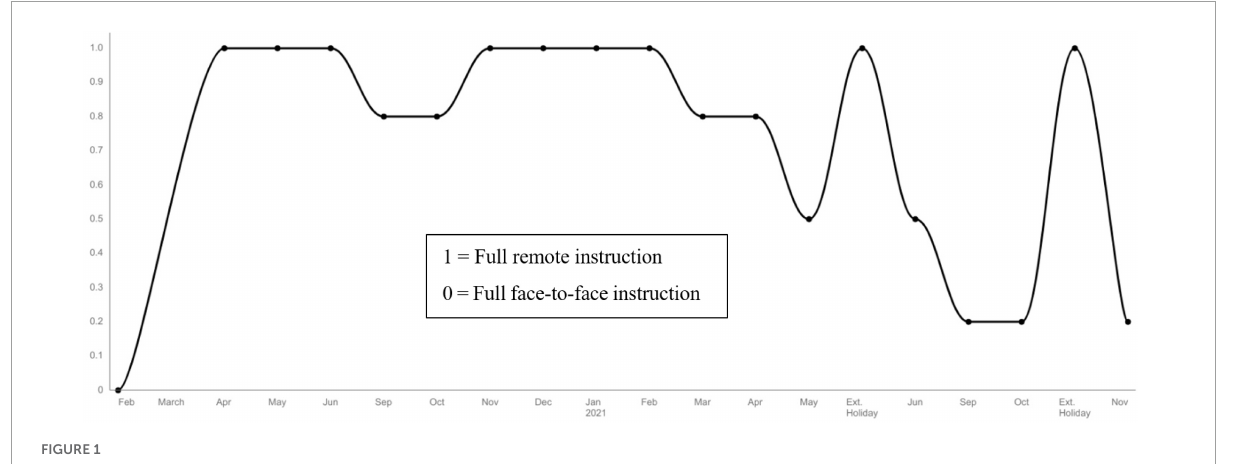
FIGURE1 RUDN University’s COVID-19 response: instruction mode (approximated, author’s